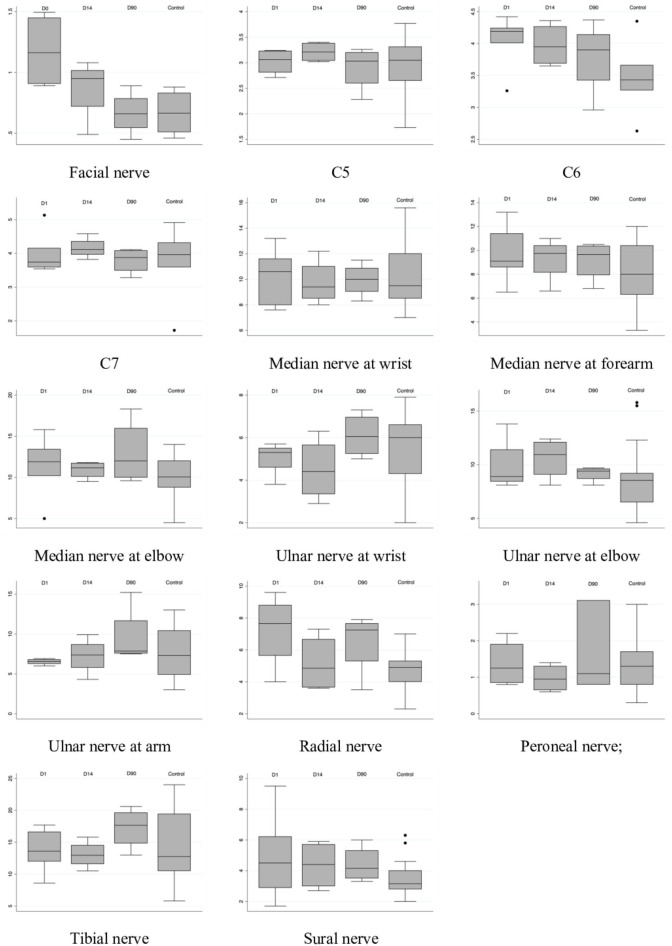
Serial nerve sonography studies for patient with MFS and control group.